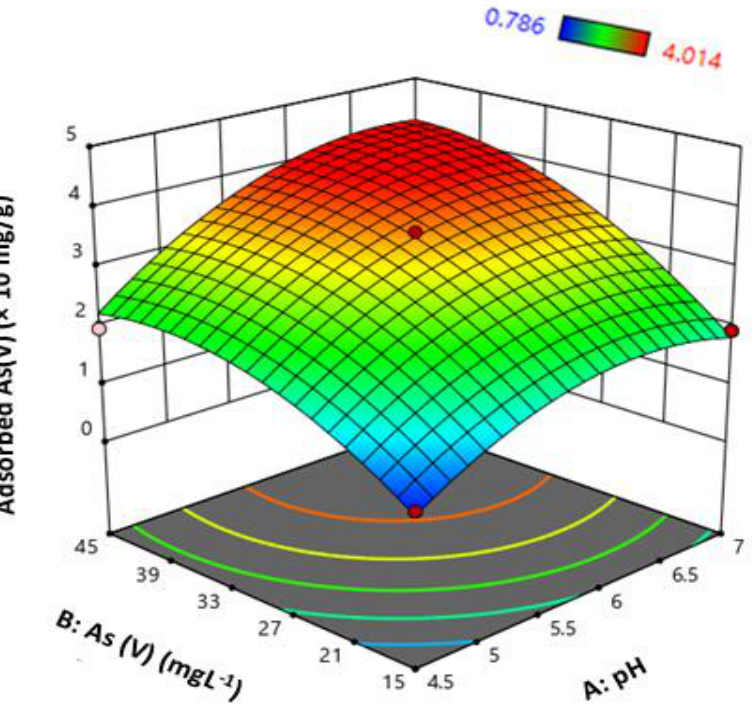
Figure 2. Response surface for (CCD)2 2 experiment of Adsorbed As(V) by BCXZM composite. Table 2. ANOVA for the quadratic model fitted for the As(V) adsorption by BCXZM composite. Source Sum of